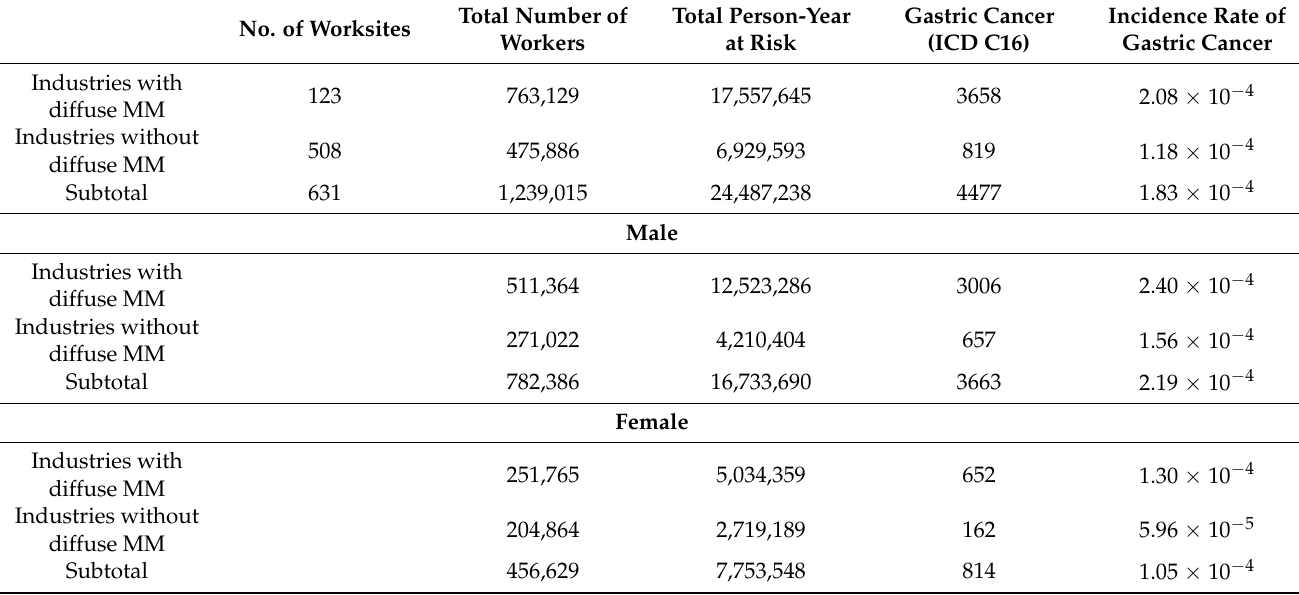
Table A1. Incidence rate of gastric cancer (male and female) among asbestos-exposed workers in industries with and without diffuse malignant mesothelioma (MM),